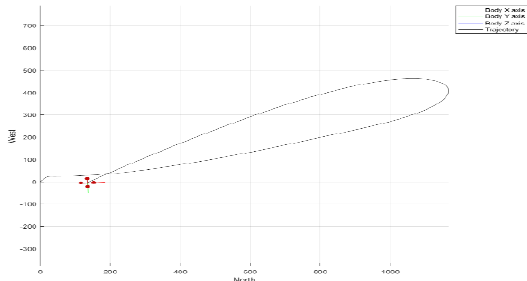
Figure 17. 2D (X-Y) view of Simulink Flight path of the